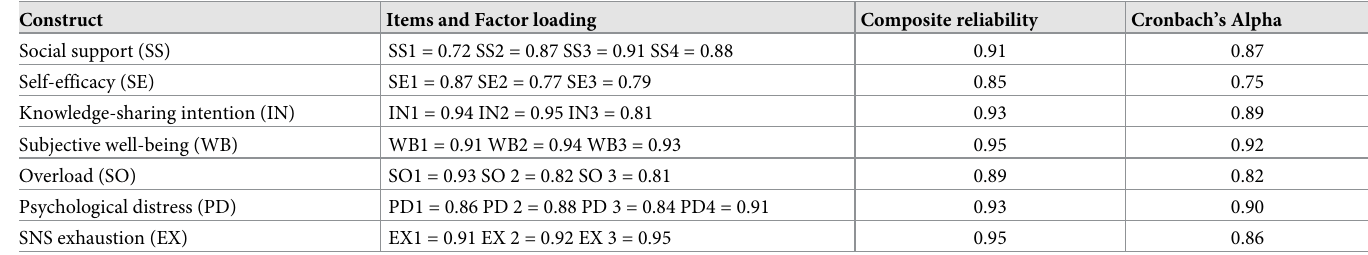
they will have more confidence when dealing with health issues and problems relating to the patient. As they believe that they can learn and improve, self-efficacy will thus increase. Second, we also highlighted the role of self-efficacy as the dominant force in shaping mem- bers’ subjective well-being in OHC. This finding suggests that when members’ self-efficacy increases, they have a more positive attitude toward their lives and help other members. Table 2. Results of reliability and convergent validity. Construct Items and Factor